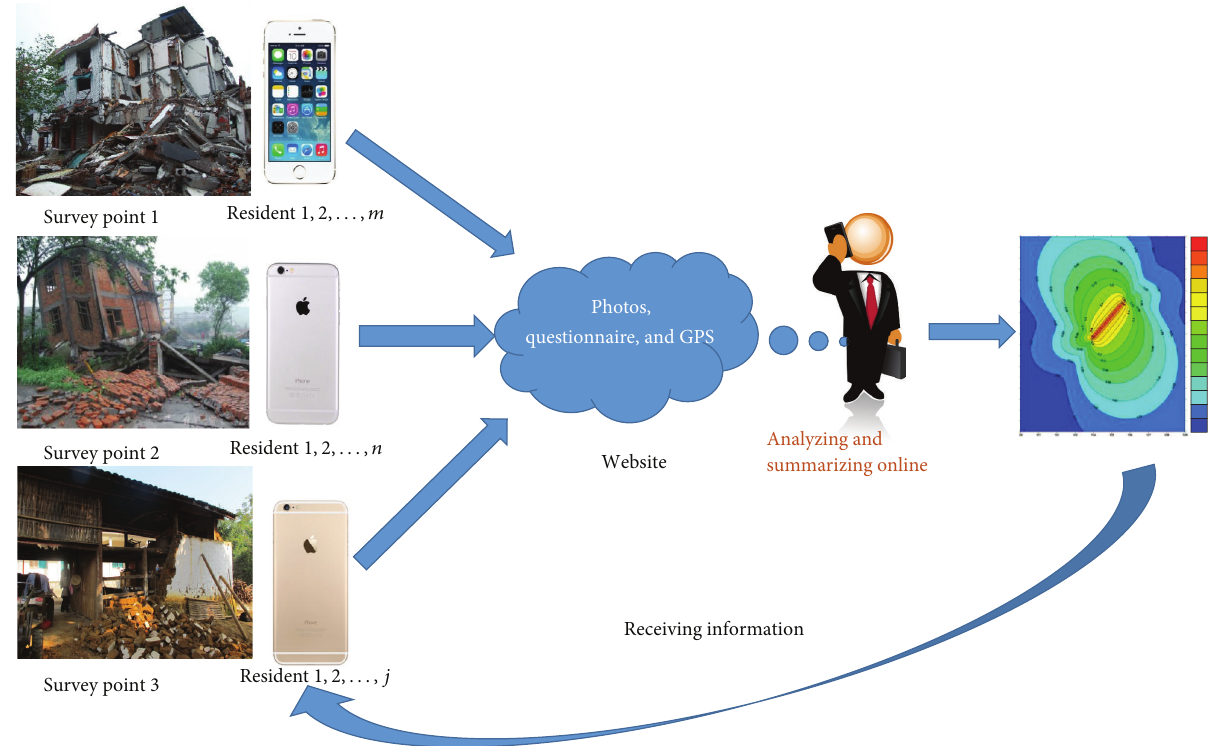
Figure 15: Flow chart of seismic damage investigation using smartphone.